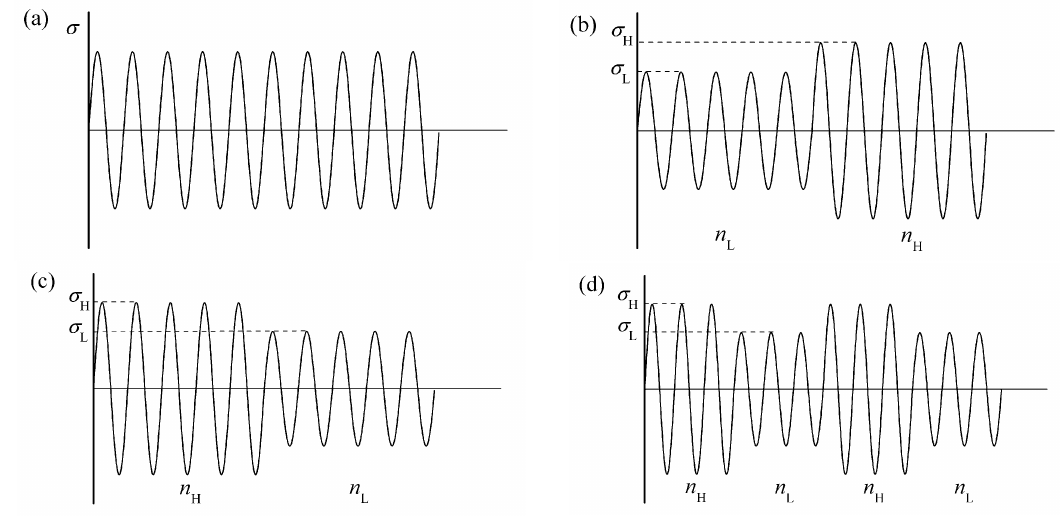
Figure 3. Schematics of ( a ) constant amplitude loading; ( b ) low-high loading; ( c ) high-low loading; ( d ) two-level repeated block loading.